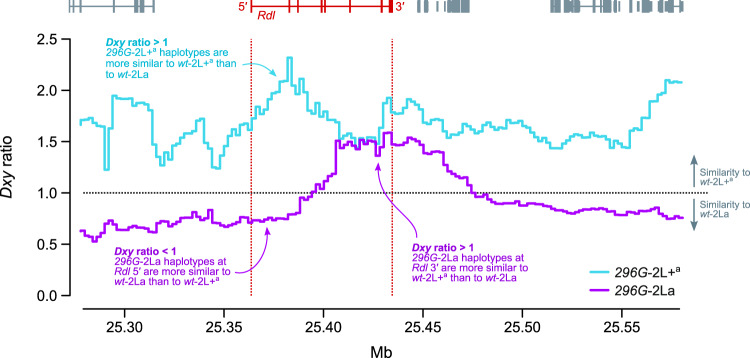
Interkaryotypic introgression of 296G haplotypes. Ratio of sequence divergence (Dxy) between 296G and wt haplotypes of 2L+a and 2La origin. In this ratio, numerators are divergences between 296G haplotypes (of either 2L+a or 2La origin, in blue and purple respectively) relative to wt-2La haplotypes, and denominators are relative to wt-2L+a. Ratios >1 indicate similarity to wt-2L+a, and values <1 indicate similarity to wt-2La. All values are calculated in windows of 20,000 kp with 10% overlap.